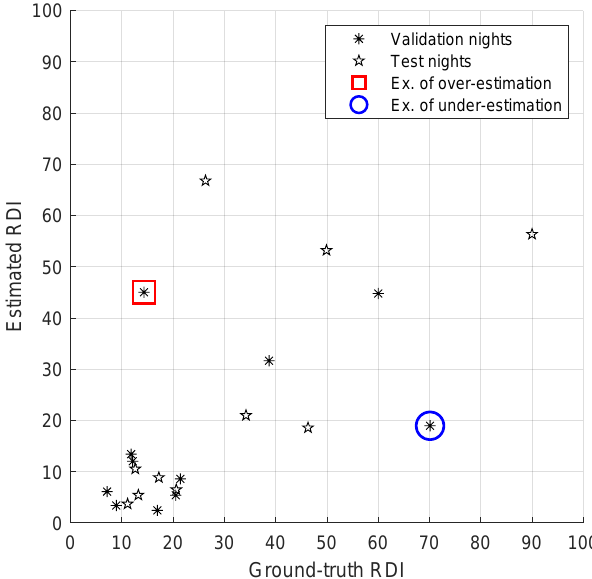
Figure 8. Results of the validation (black asterisks—correlation of 0.49) and on the test datasets (black stars—correlation of 0.66); we highlight a case of over-estimation (red square), as detailed in Figure 10, and of a case of low sensitivity (blue circle), as detailed in Figure 11; x -axis: reference RDI; y -axis: estimator’s